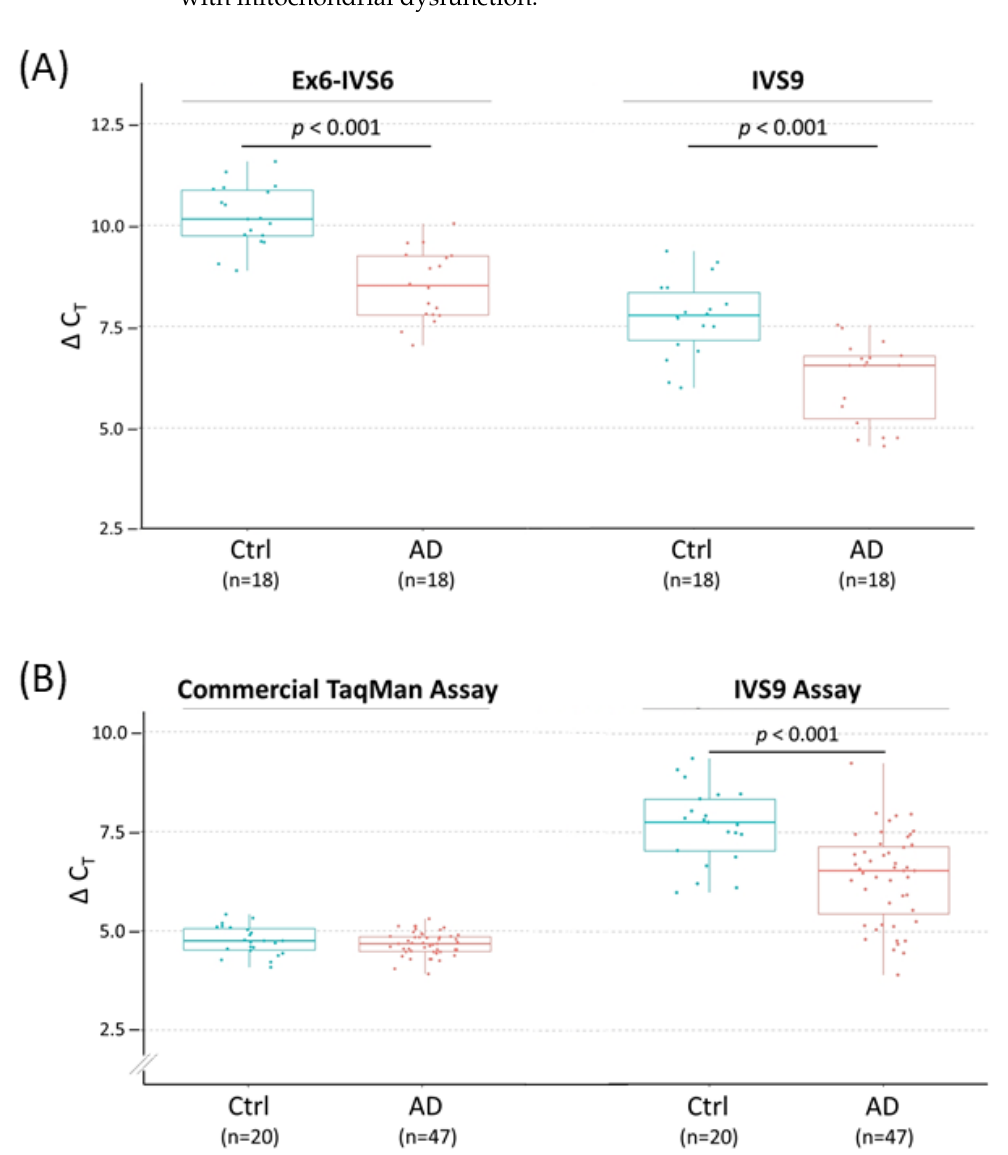
Figure 4. TOMM40 RNA transcript levels in human PMB tissues by RT-qPCR quantification. Transcription levels of TOMM40 RNAs are plotted as values of ∆ C T (mean of C T triplicates (target)—mean of ACTB C T triplicates) and compared between control (Ctrl) (blue) and AD (red) frontal lobes. In this setting, smaller ∆ C T values indicate higher RNA levels. ( A ) Comparison of the two TOMM40 primary transcript-targeted assays (Ex6-IVS6 vs. IVS9) as the pilot study. ( B ) Compari- son of a commercial TaqMan cDNA assay (Thermo Fisher, assay Hs01587378_mH) and the primary transcript-targeted TaqMan IVS9 assay with expanded samples. Numbers in parentheses denote sample size. The t -test p values are shown where significant differences between Ctrl and AD were detected. Boxplot shows quartiles and